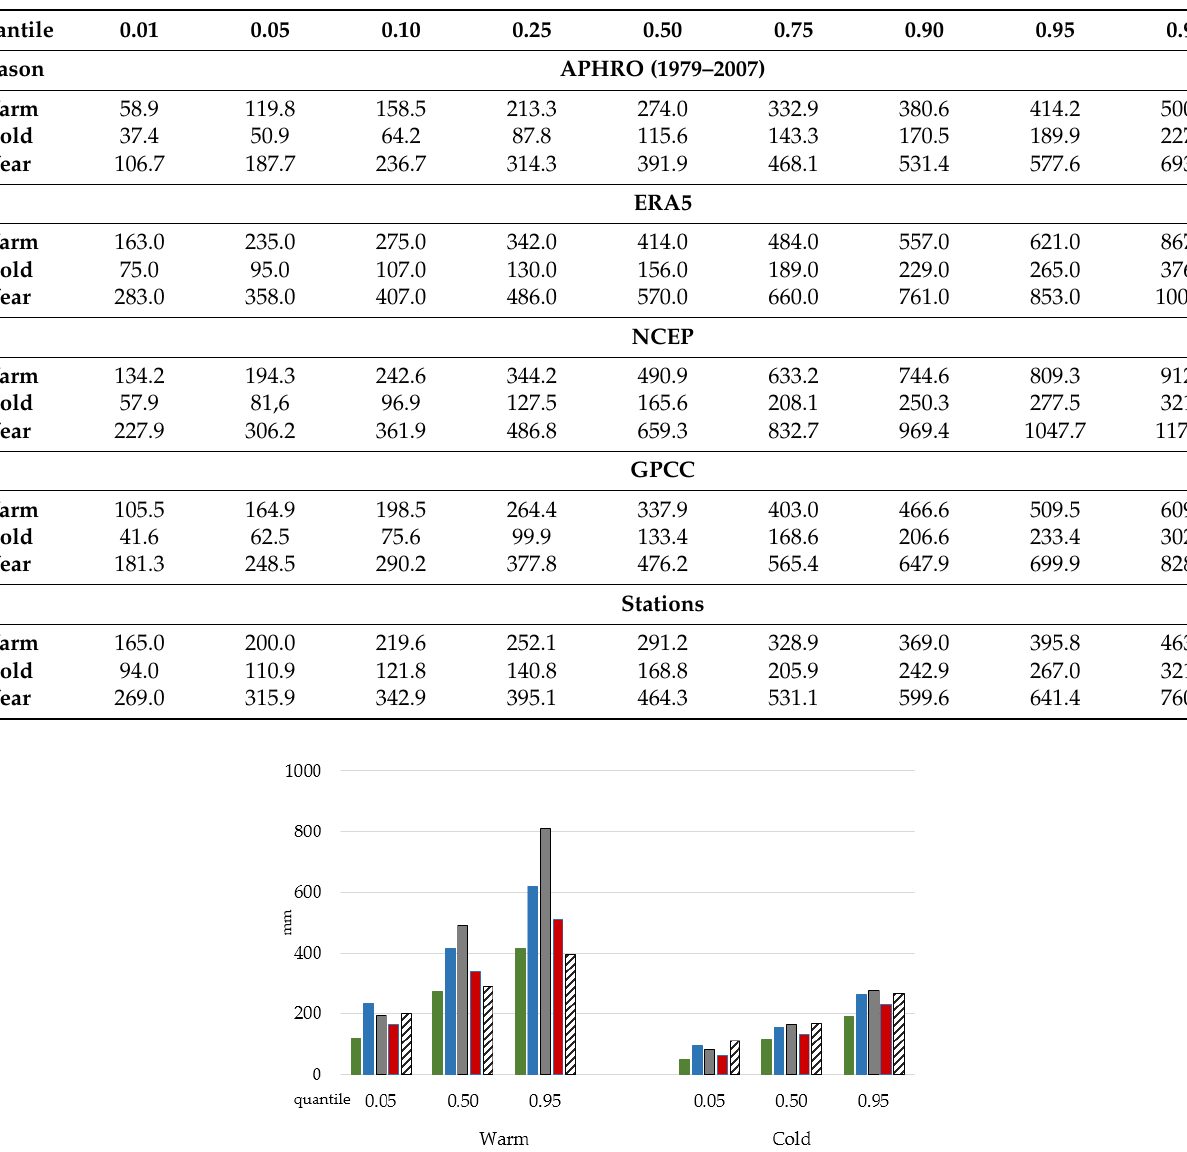
Table 1. The distribution of the precipitation values by the threshold quantiles.